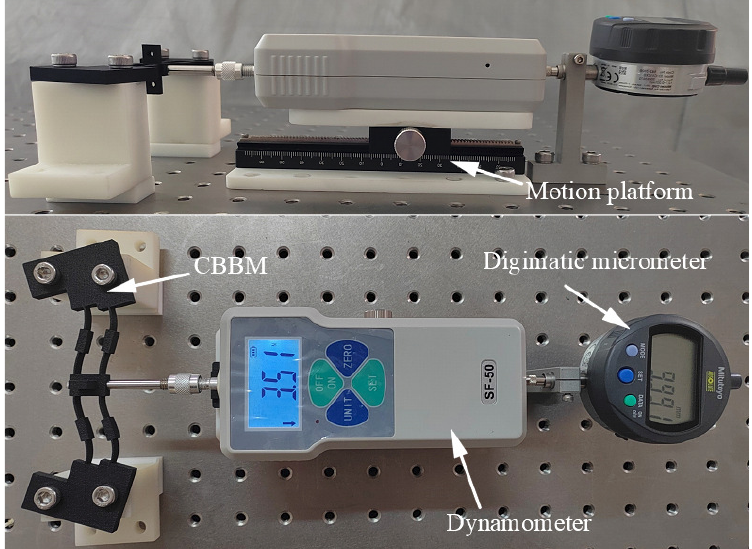
Figure 14. Experimental setup for measuring force − displacement